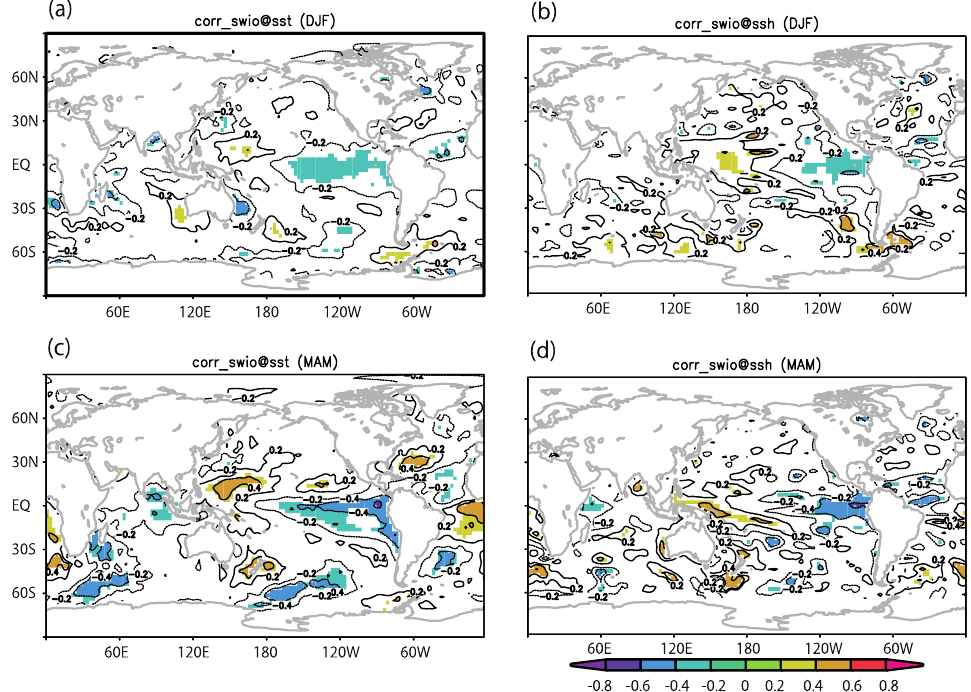
Figure 2. Simultaneous correlation map of SST (left panels) and SSH (right panels) anomalies with the TCF anomaly (defined as occurrence in 5° × 5° bins, units are TCs per season) averaged over the SWIO region (averaged over 10 – 30° S, 40 – 70° E). Significant areas above the 90% confidence level are shaded. Correlation map of ( a ) DJF SST, ( b ) DJF SSH, ( c ) MAM SST, ( d ) MAM SSH.